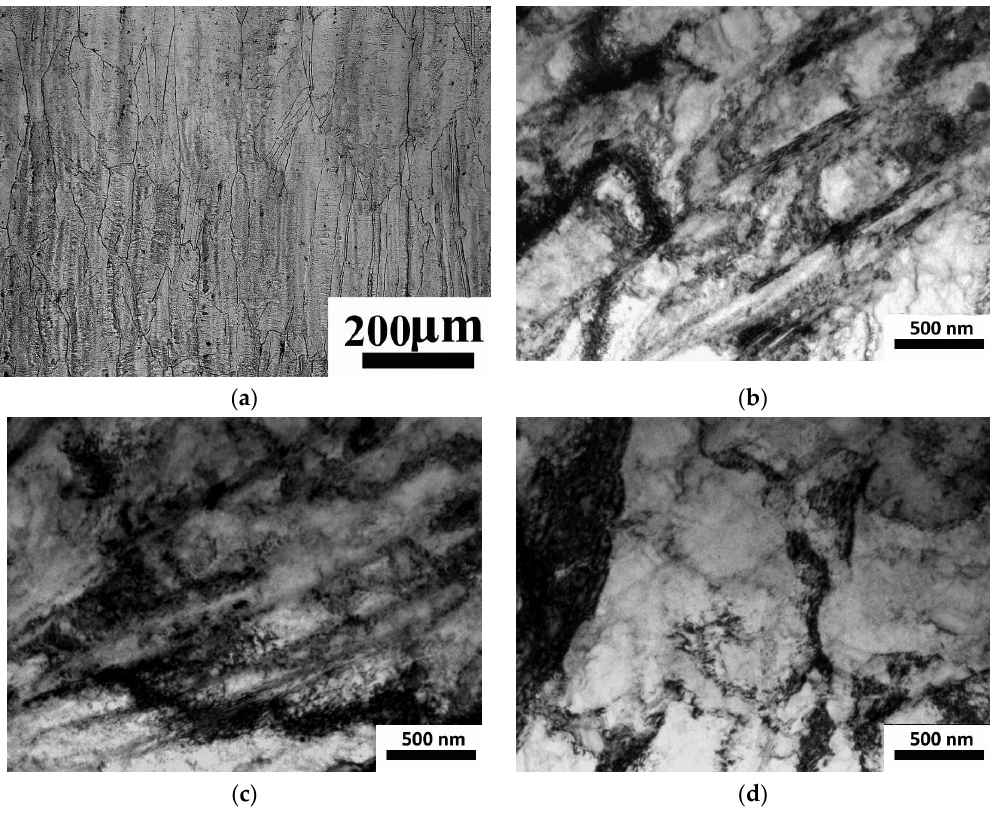
Figure 5. Microstructure of the austenitic steel after rolling to a total reduction in area of 77% (“Rol” condition): ( a ) optical microscopy; ( b – d ) TEM.